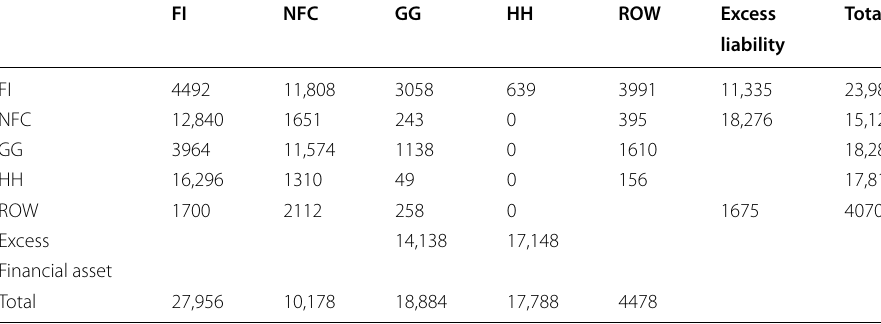
Table 4 FFS Table for China (in units of 1 billion USD)